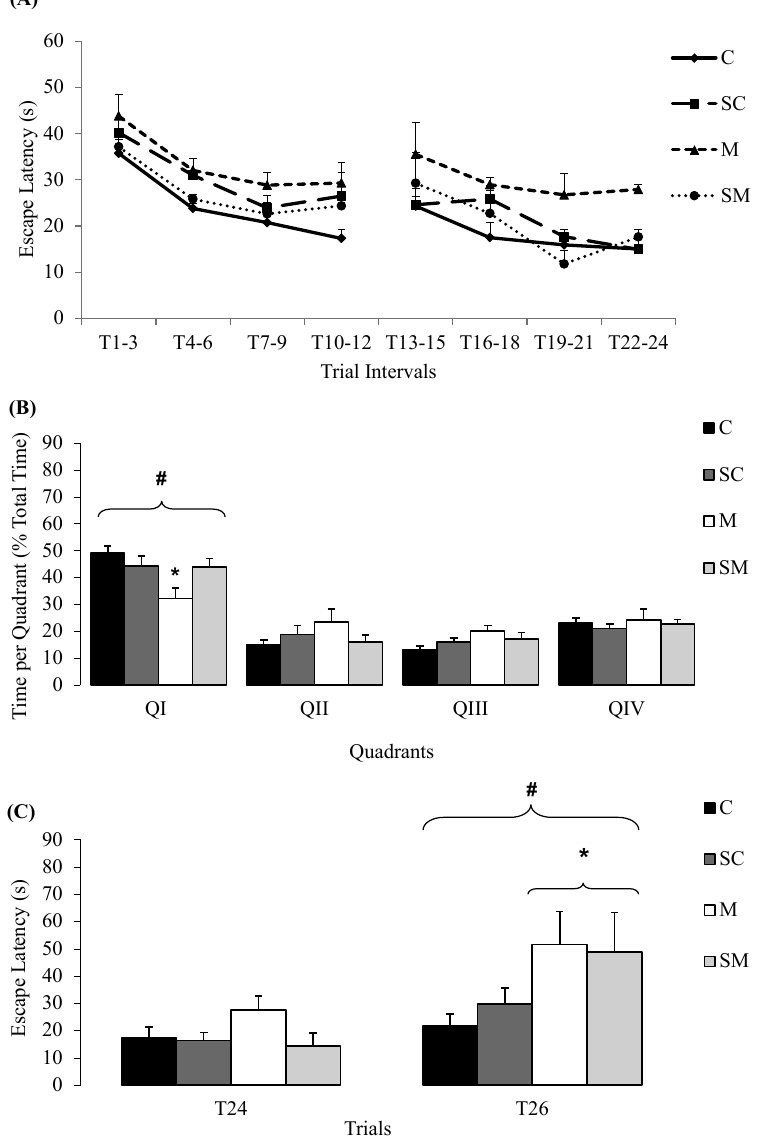
Figure 2 . A: Escape latency (Mean + SEM) of the 4 groups in Experiment II, C ( n =14), SC ( n =12), M ( n =12), SM ( n =12), in the 24 trials of the fi rst phase of MWM test. B: Percent time spent in each of the four quadrants of the MWM (Mean + SEM) by animals of the four groups on probe trial in Experiment II. # p <.05 compared to QII, QIII e QIV (Newman-Keuls test). C: Escape latency (Mean + SEM) of the 4 groups in Experiment II, in the last trial of the fi rst phase (24 th trial) and 28 days later (26 th trial). # p <.05 compared to 24 th trial; * p <.05 compared to controls in the same trial and to malnourished and control animals in the 24 th trial (Newman-Keuls